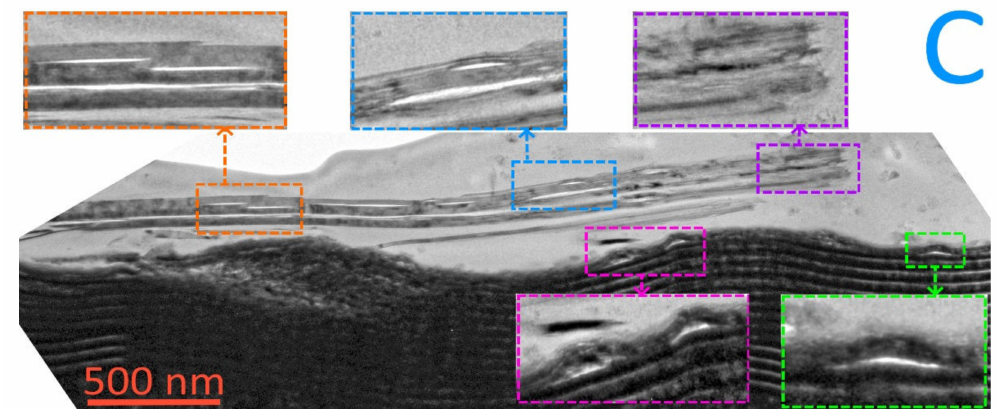
Figure 6. Analysis of the structure of oxidized layers in the (Zr,Mo,Al)N coating.